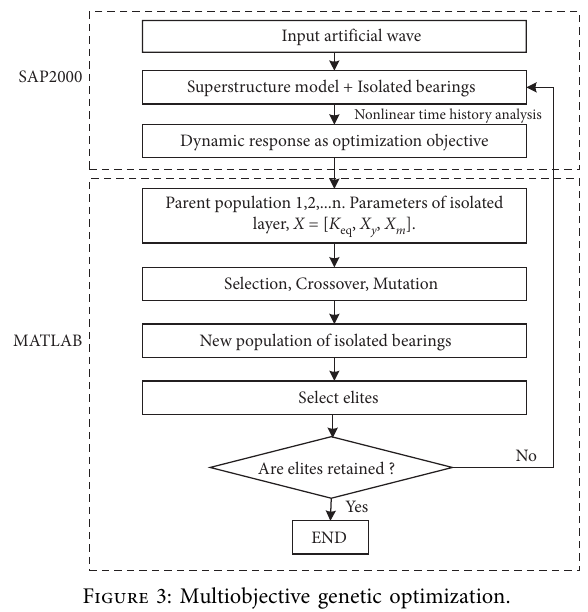
Figure 3: Multiobjective genetic